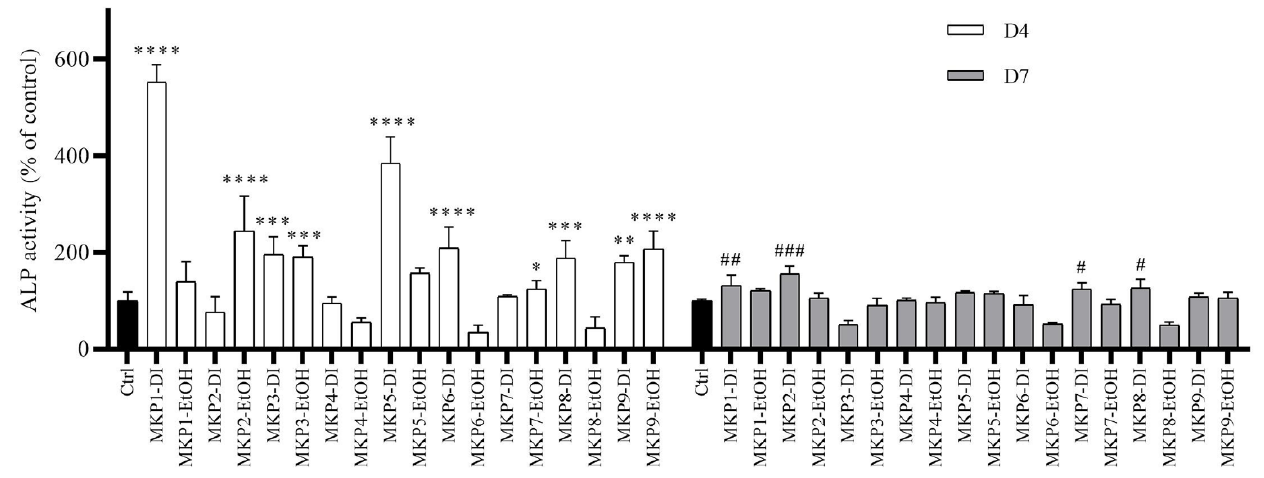
Figure 3. The results show the alkaline phosphatase activity (% of control) of osteoblast-like MG-63 cells after being cultured for 4 and 7 days with different medicinal plant extracts (conc. 25 µg/mL) or only DMEM as control. Data are expressed as mean ± SD where n = 3 (significant levels at *, #: p < 0.05; **, ##: p < 0.01; ***, ###: p < 0.001; and ****: p < 0.0001, respectively, when compared to control).